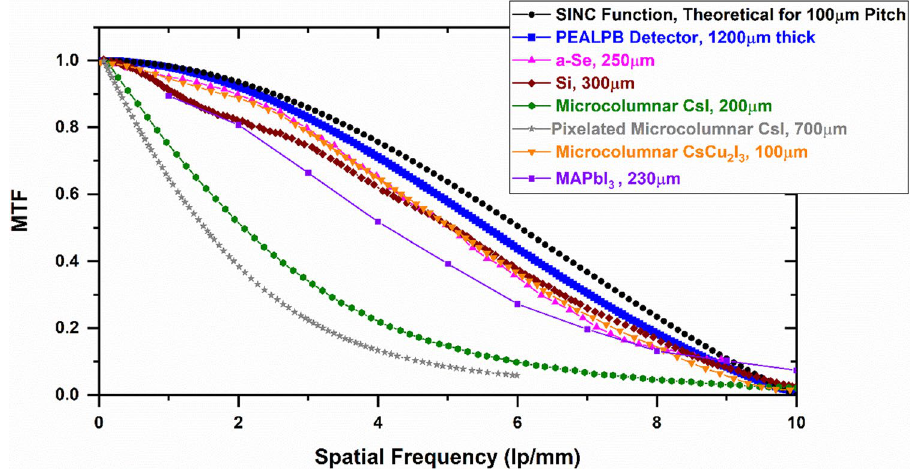
Figure 8. MTF curve of PEALPB detectors along with other state-of-the-art detectors with relatively lower thicknesses. The plot thicknesses are representative of the sensor thickness levels. The sync function plot corresponding to a 100 µm pixel pitch is also shown for reference.